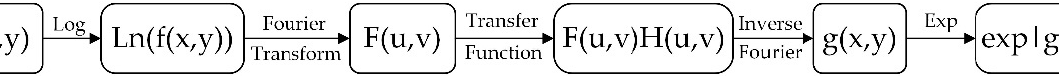
Figure 1. The process of homomorphic filtering.